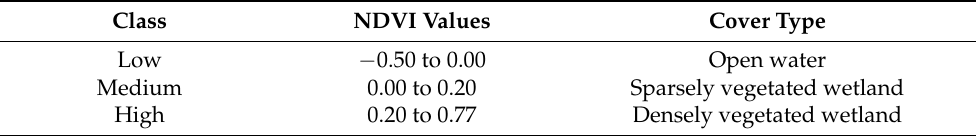
Table 3. NDVI cut-off values for classifying vegetation status in the identified